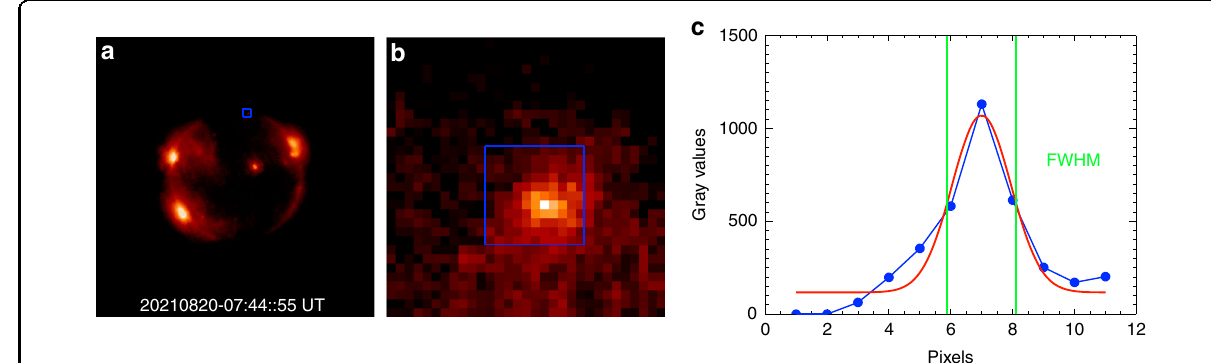
Fig. 8 The observation of a point target to reveal the resolution of X-EUVI. The point target in a is marked in the blue rectangle, b is the enlarged view of the point target, and c is horizontal line across the peak